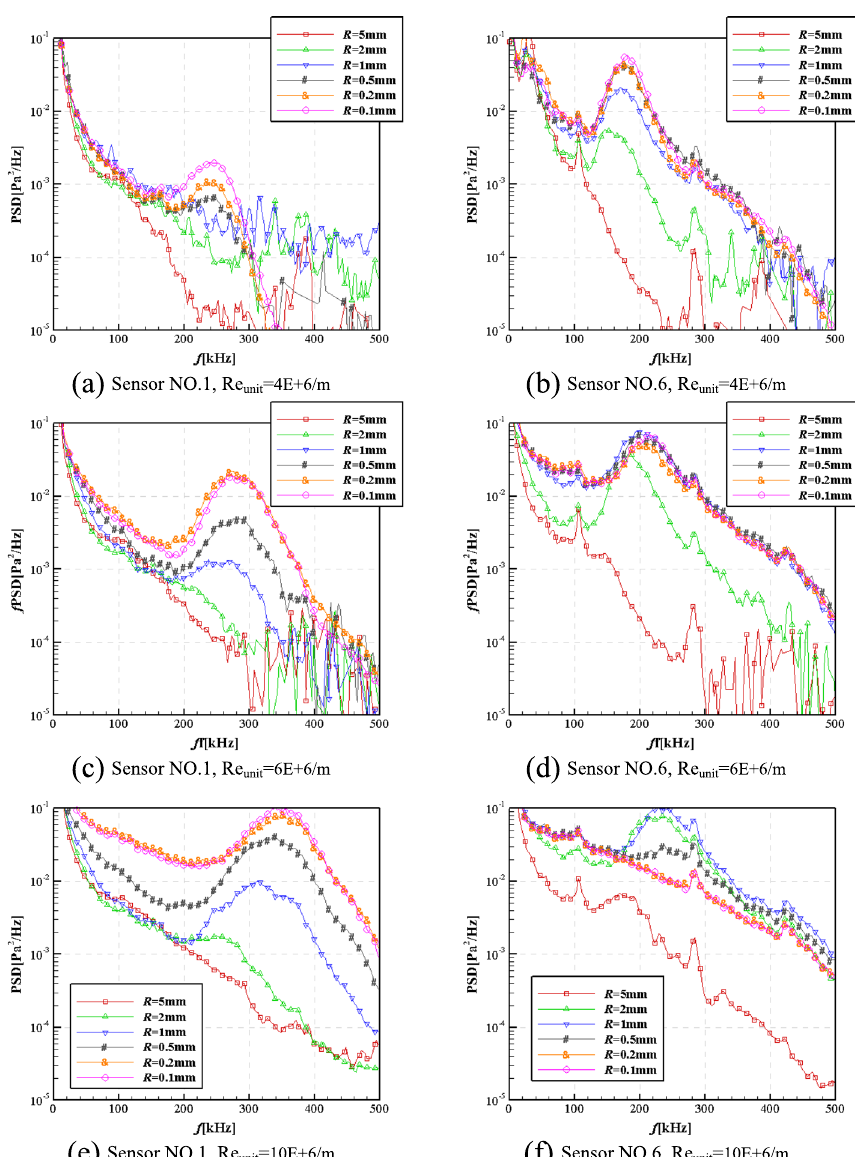
Fig. 13 PSD of wall pressure fluctuations at different streamwise locations. Sensor NO. 1 is located at x 182.6 mm, while sensor NO. 6 is located at x =